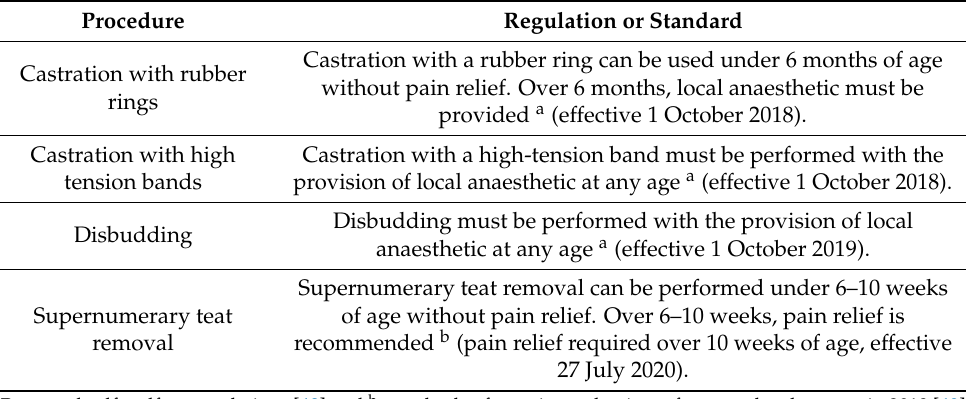
Table 1. Proposed welfare regulations or standards of practice in New Zealand regarding the provision of pain management for certain husbandry procedures at the time of survey